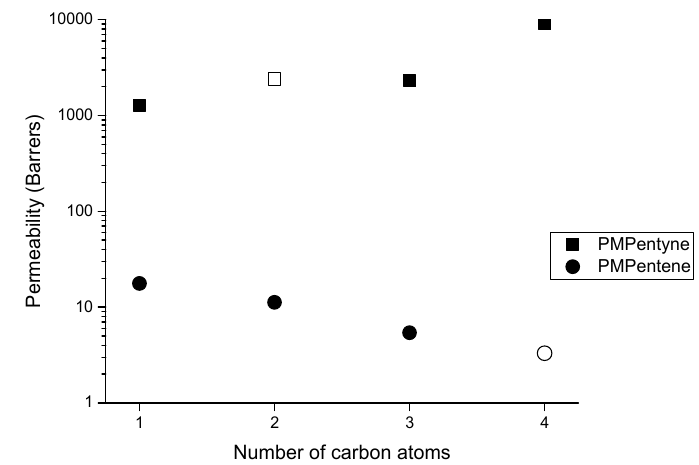
Figure 6. Permeability coe ffi cients of PMPentyne and PMPentene at 25 ◦ C. (cid:4) , • experimental data; (cid:3) , data calculated using correlation approach (Equations (7)–(9)). (cid:35)